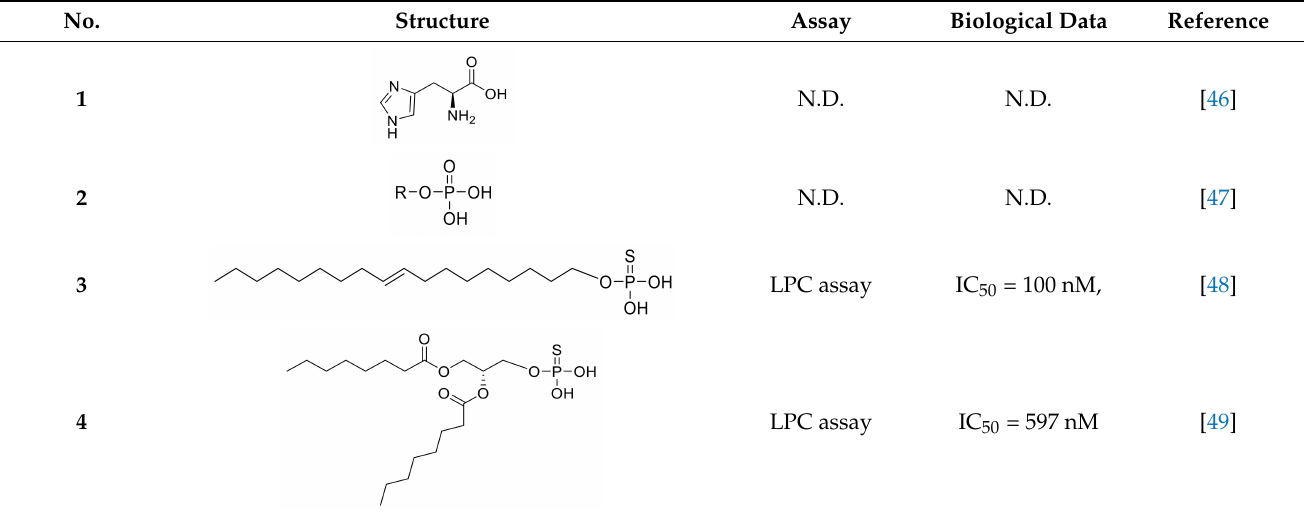
Table 1. Compound 1 – 11